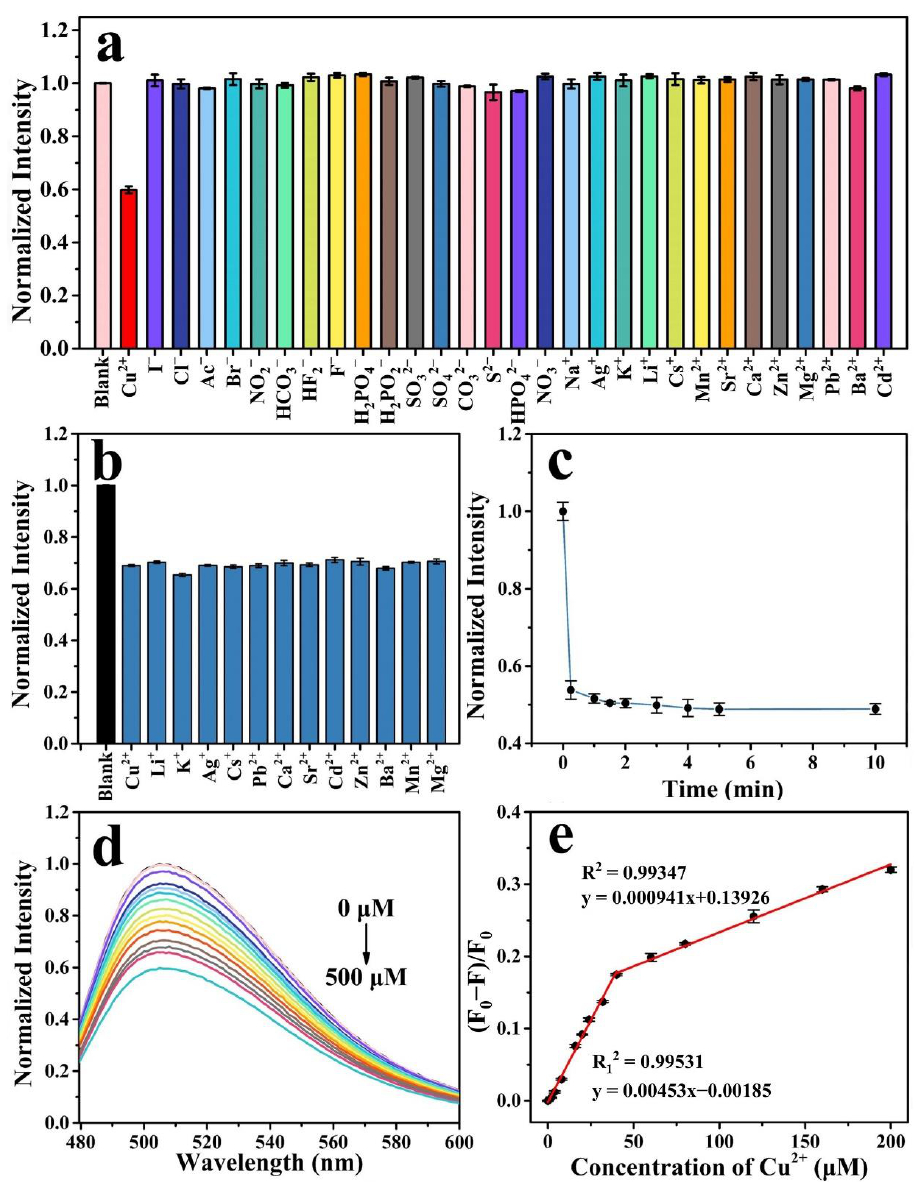
Figure 5. ( a ) Fluorescence response of the N, F-CDs to the various metal ions and anions at a concentration of 500 µ M. ( b ) Anti-interference ability of the N, F-CDs in Cu 2+ detection. ( c ) Reaction time after the addition of Cu 2+ . ( d ) Fluorescence emission spectra of the N, F-CDs at different Cu 2+ concentrations (from top to bottom: 0 –500 μM). ( e ) The linear relationship between the ratio of fluorescence intensity ((F 0 − F)/F 0 ) changes and Cu 2+ concentrations (0 –200 μM).